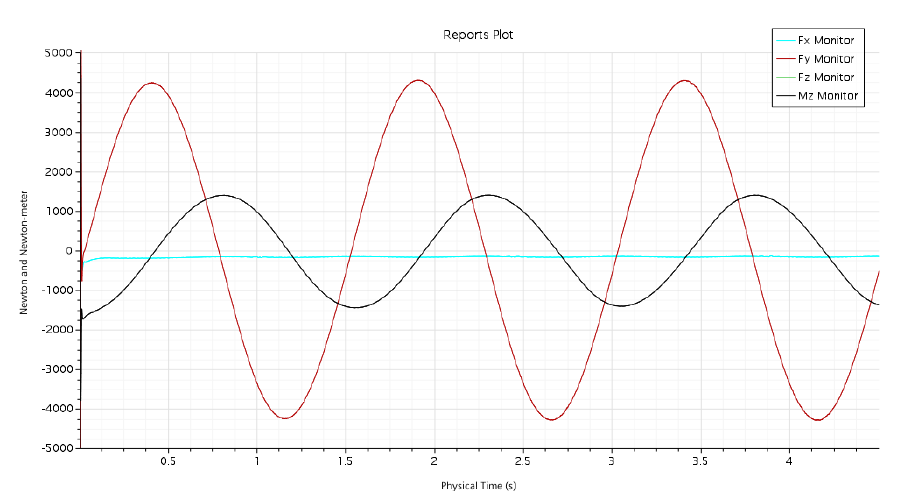
Figure 2. Sway force and yaw moment time history recorded during a virtual planar motion mechanism run.